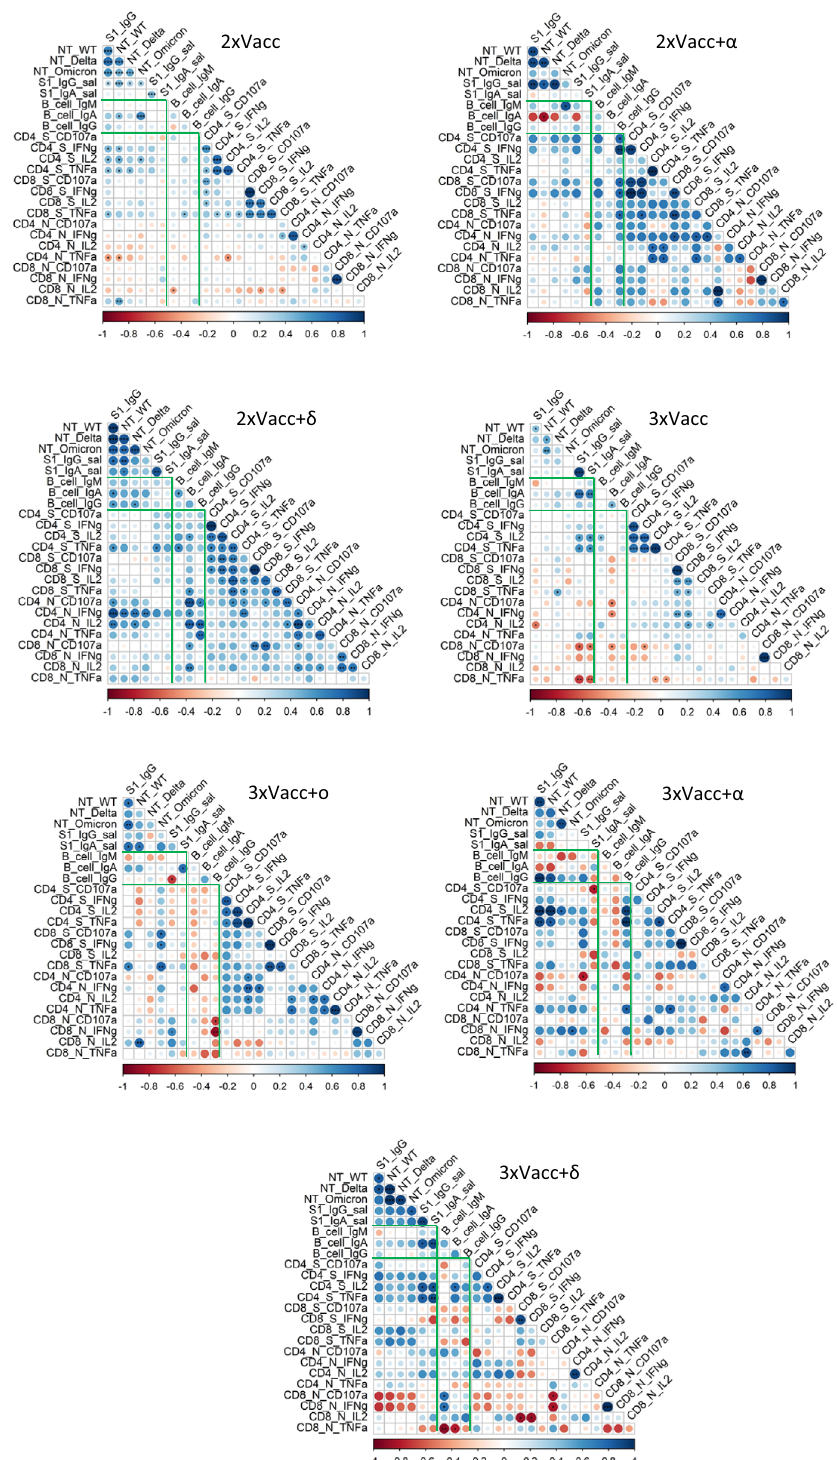
Fig. 5 | Correlation between the parameters of the adaptive immune response to different antigen exposure scenarios. Correlation matrices demonstrate the strengthofcorrelationsbetweenthemeasuredimmuneparametersforeachofthe antigen exposure groups. The strength of a correlation (Spearman ’ s correlation coef fi cient) is depicted by the size and color of the circle, signi fi cance is indicated by asterisks. The exact p values are given in the Source data fi le. Green lines separate correlations between different branches of the measured immune para- meters; antibodies, memory B cells, and T cells. The following numbers of